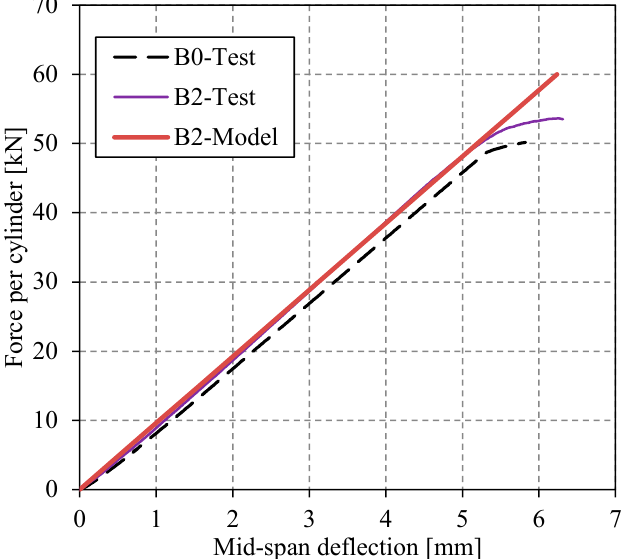
Figure 10. The load-deflection behavior of reference specimen B0 and specimen B2 (retrofitted with the un-bonded NM CFRP plate).